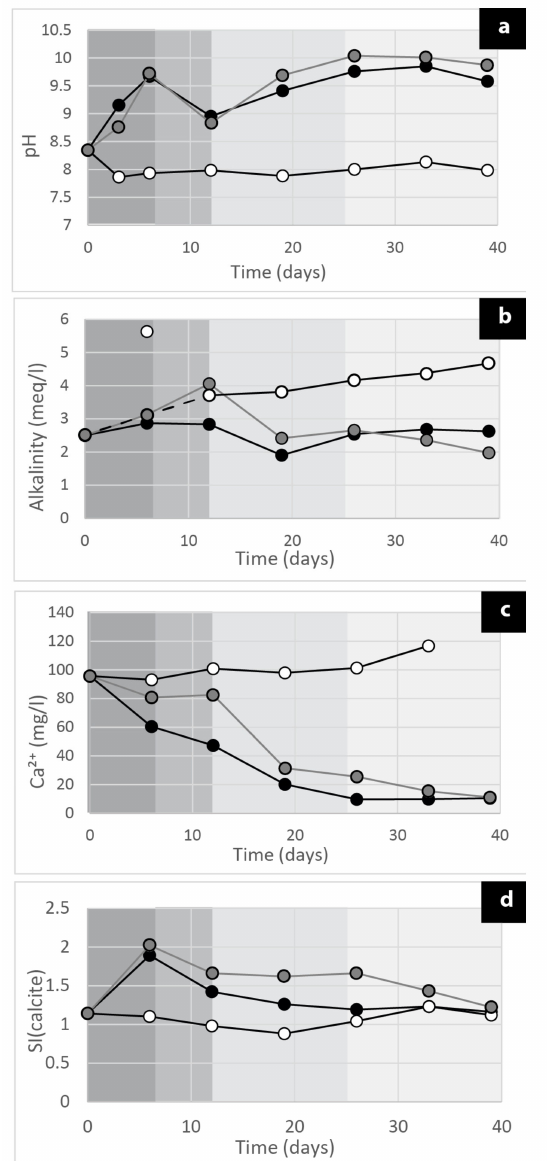
Figure 12. Time series of key physicochemical properties during the precipitation experiment (the data shown for Treatment E as a typical example); temporal evolution of ( a ) the pH, ( b ) the alkalinity, ( c ) the Ca 2 + concentration and ( d ) the calcite saturation index (SI). Closed symbols (black and grey) are replicate biological incubations, open symbols indicate the abiotic controls. The observed alkalinity increase in the abiotic control after three days is surprising and cannot be accounted for. When